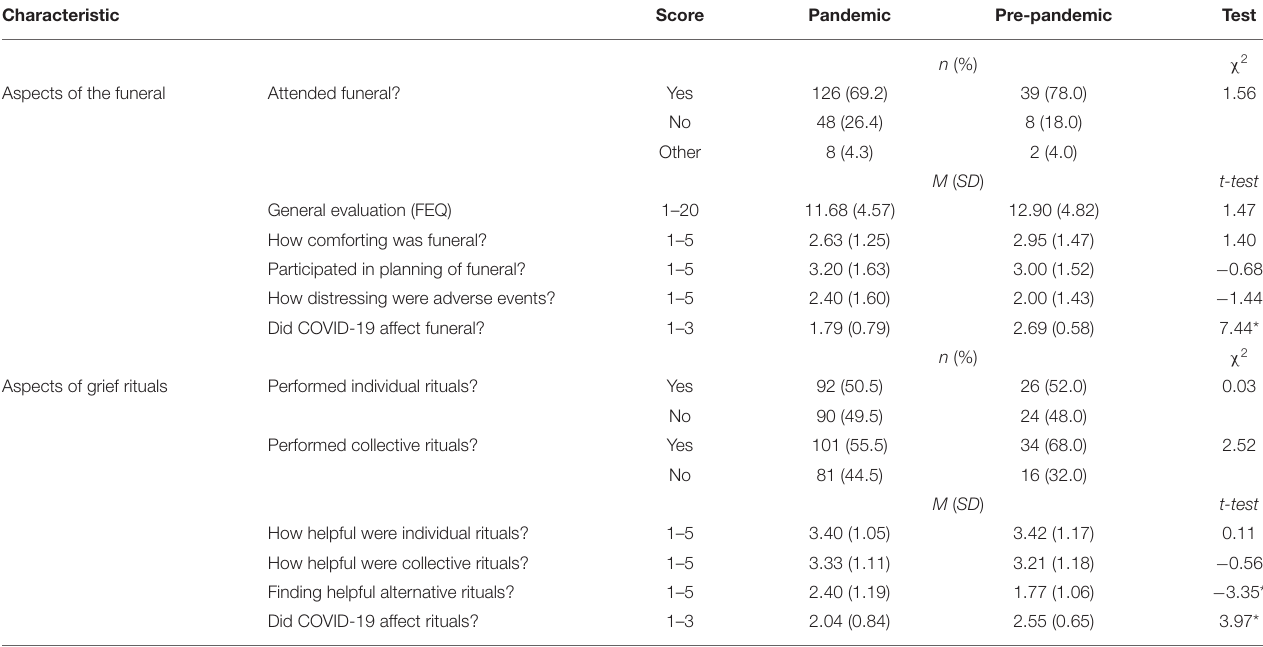
TABLE 2 | Aspects of the funeral, grief rituals and group differences ( n = 232).